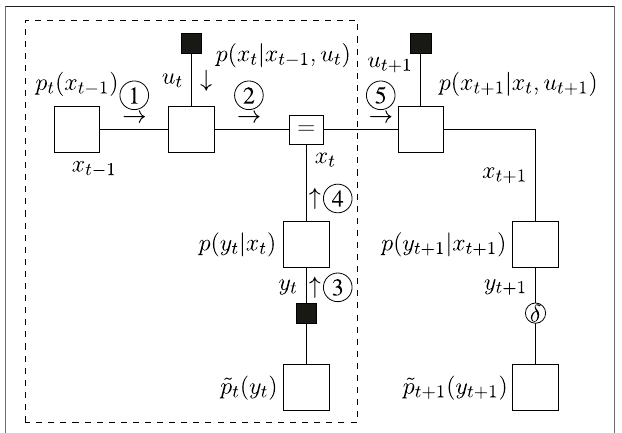
FIGURE 9 | Message passing schedule for the slide